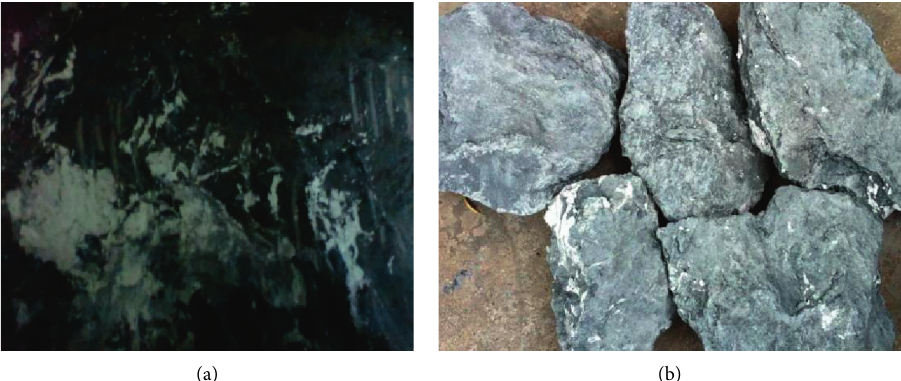
Figure 6: Rock specimens at XJ1K0+350. (a) Surrounding rock. (b) Rock specimens.